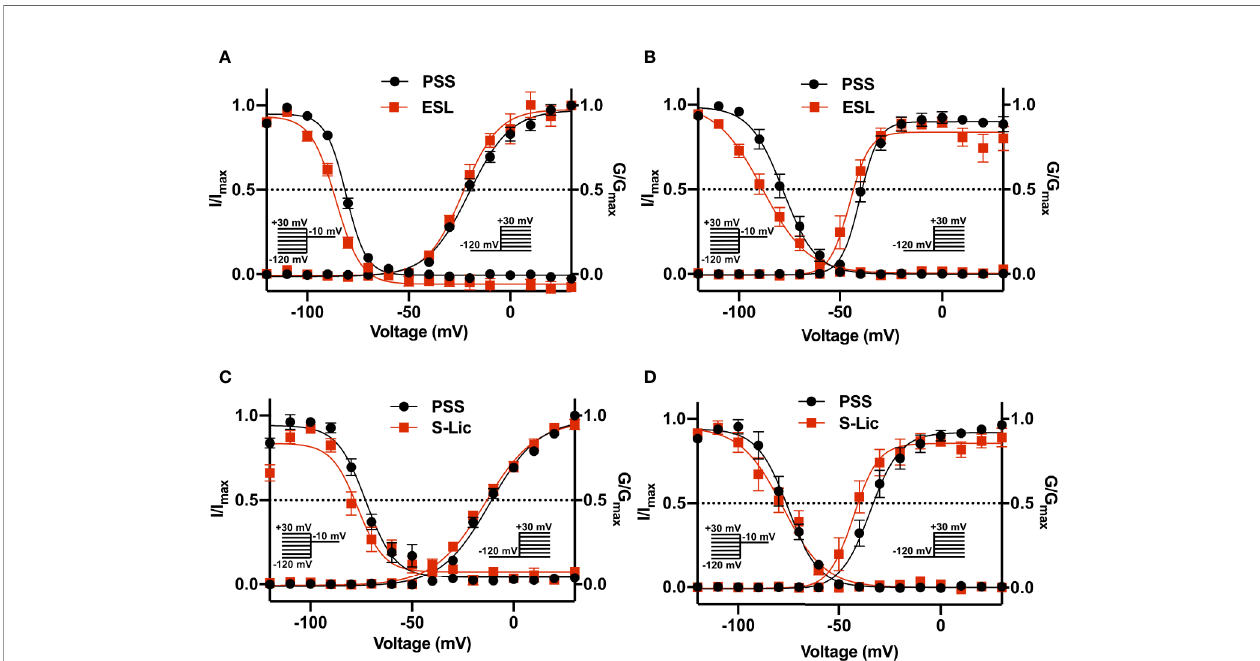
FIGURE 5 | Effect of eslicarbazepine acetate and S-licarbazepine on activation and steady-state inactivation. (A) Activation and steady-state inactivation in MDA- MB-231 cells in physiological saline solution (PSS; black circles) and in eslicarbazepine acetate (ESL; 300 m M; red squares). (B) Activation and steady-state inactivation in HEK-Na v 1.5 cells in PSS (black circles) and ESL (300 m M; red squares). (C) Activation and steady-state inactivation in MDA-MB-231 cells in PSS (black circles) and S-licarbazepine (S-Lic; 300 m M; red squares). (D) Activation and steady-state inactivation in HEK-Na v 1.5 cells in PSS (black circles) and S-Lic (300 m M; red squares). For activation, normalized conductance (G/G max ) was calculated from the current data and plotted as a function of voltage. For steady-state inactivation, normalized current (I/I max ), elicited by 50 ms test pulses at -10 mV following 250 ms conditioning voltage pulses between -120 and +30 mV, applied from a holding potential of -120 mV, was plotted as a function of the prepulse voltage. Results are mean ± SEM (n = 7 – 13). Activation and inactivation curves are fi tted with Boltzmann